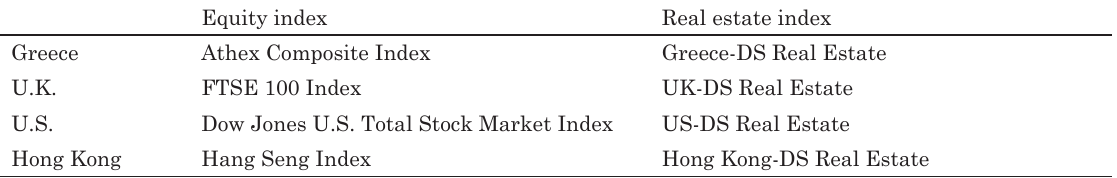
Table 1. The equity and real estate indices chosen Equity index Greece Athex Composite Index Greece-DS Real Estate U.K. FTSE 100 Index